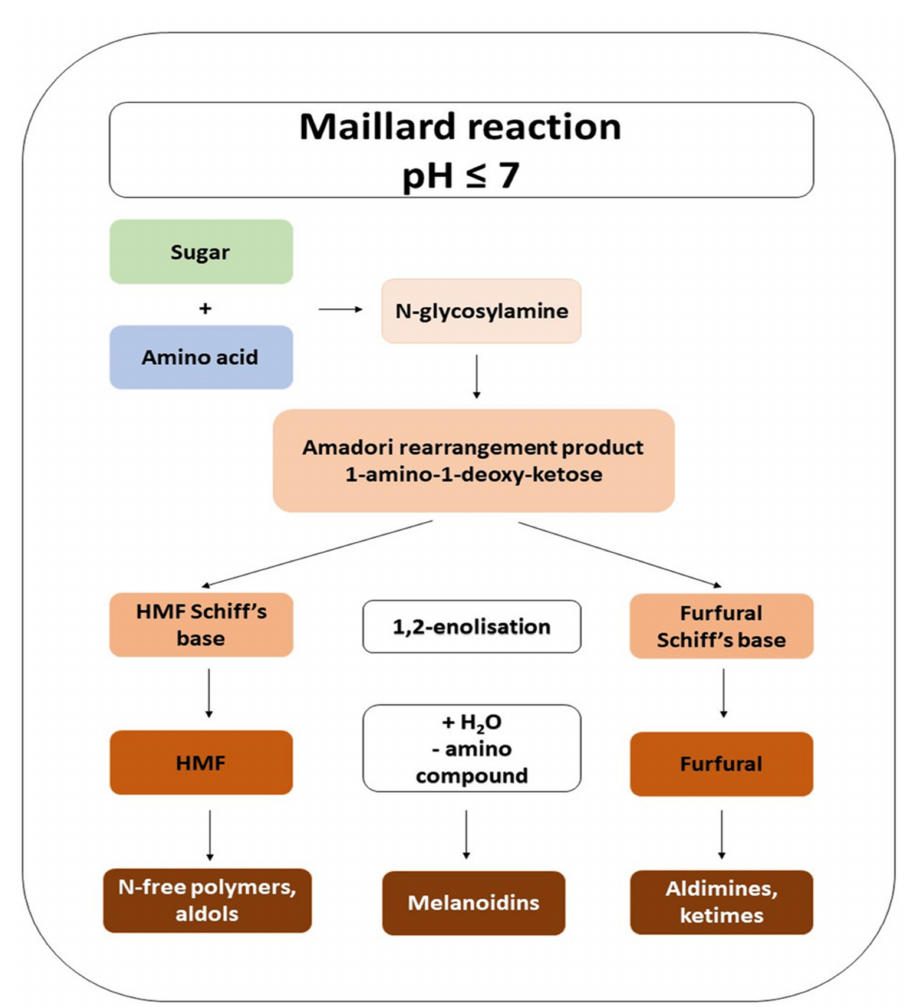
Figure 2. Maillard reaction mechanism modified on the basis of Singla et al.